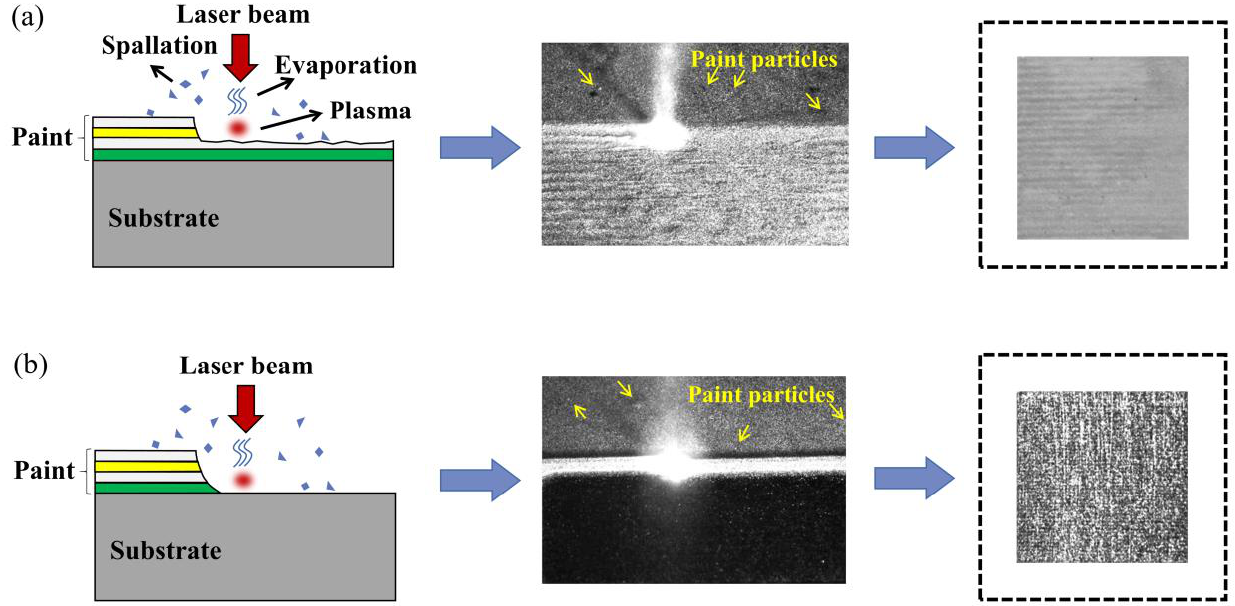
Figure 12. Schematic diagram of laser paint-stripping mechanisms: ( a ) mechanisms for incompletely removing paint, ( b ) mechanisms for completely removing paint.